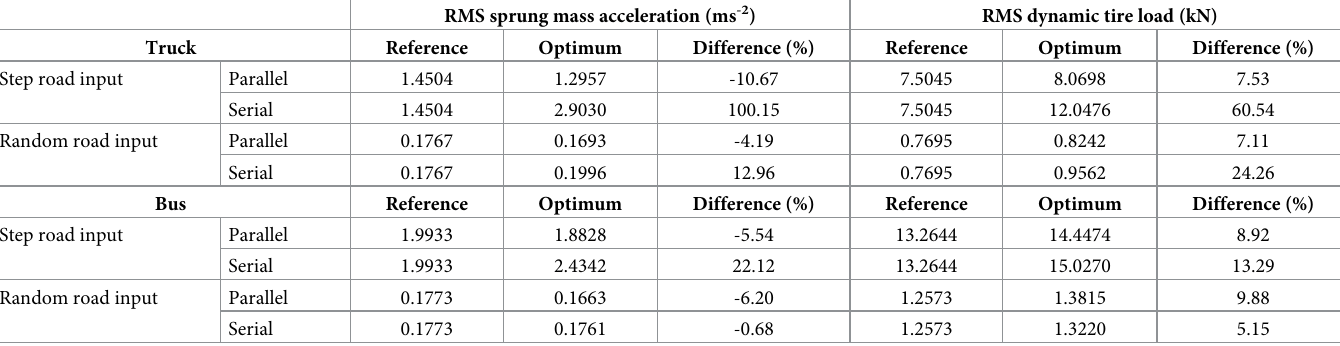
Table 2. Summary and comparison of heavy vehicle suspension performance due to different road